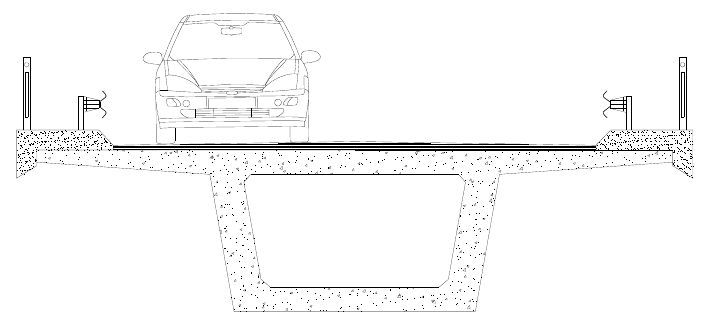
Figure 1. Example of a hollow (box) cross-section for the girder of a bridge deck.